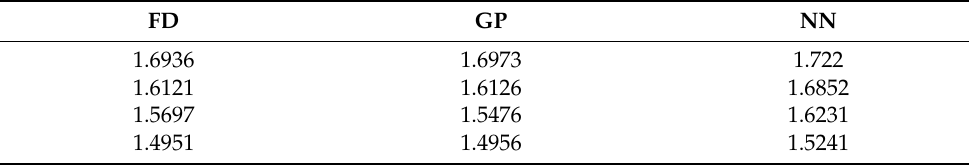
Table 2. Calculated and predicted complexity of the